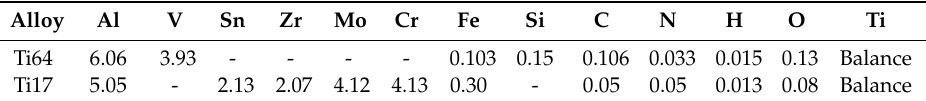
Table 1. Chemical compositions of base metals (wt.